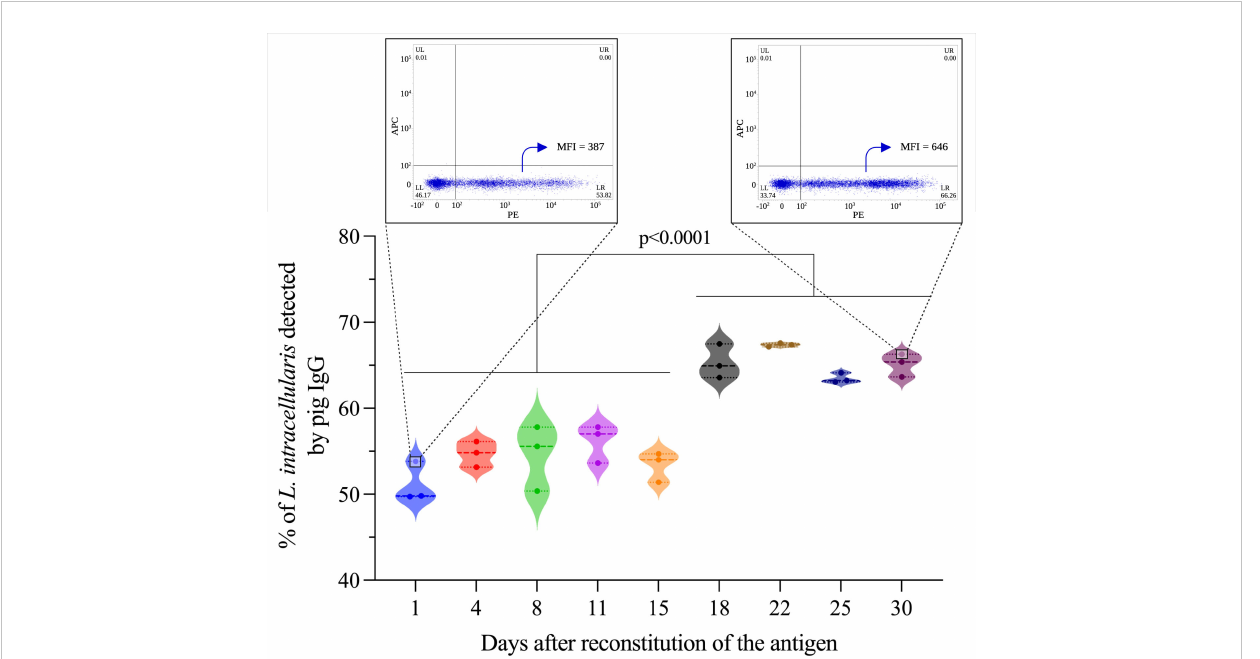
FIGURE 3 Antigenicity analysis of the reconstituted antigen. This analysis was performed by fl ow cytometry using sera (n=3) from pigs immunized with the Porcilis ® Ileitis vaccine. The results express the percentage of L. intracellularis bacteria (total population containing 10 6 bacteria) containing antibodies (IgGs) surface. Statistical comparison was performed using one-way ANOVA with Tukey ’ s multiple comparisons, and statistical differences are represented in the fi gure. Dot plots showing antigenic differences between time D1 and D30 are highlighted in zoom format within the fi